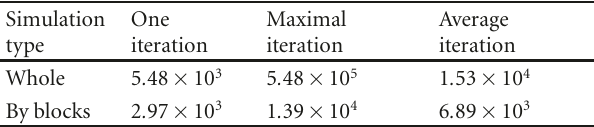
Table 4: Computational complexity comparison of simulations based on the Newton method—number of